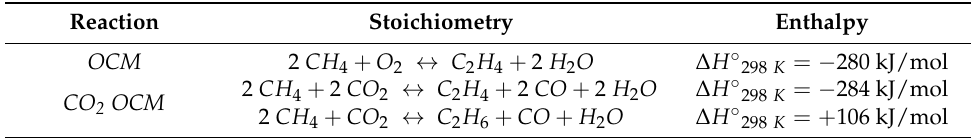
Table 22. Main reactions involved in the OCM and CO 2 OCM processes.